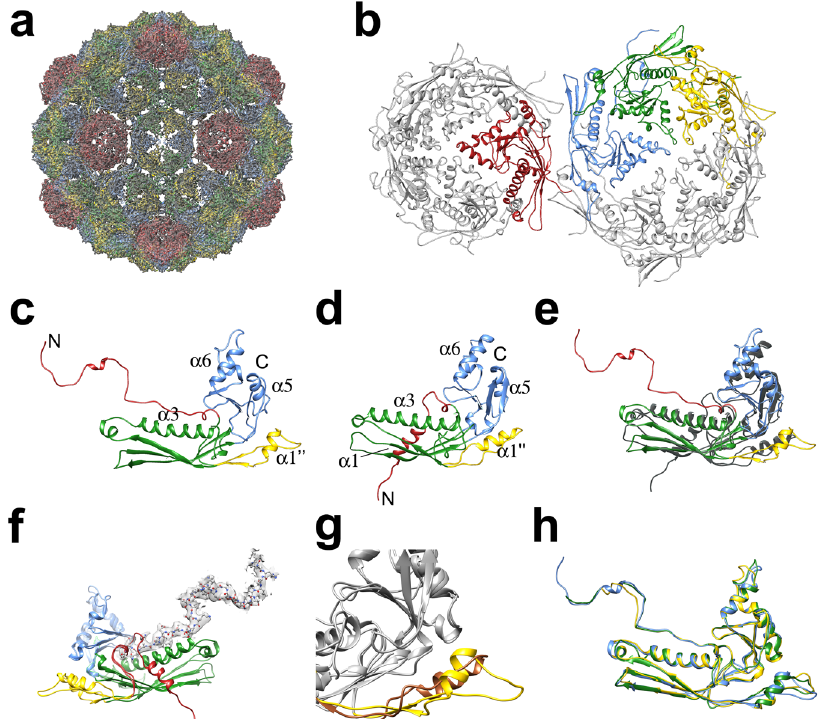
Fig. 6 Atomic model of the SaPIbov5 procapsid. a Ribbon representation of the atomic model for the complete shell fi tted into the density. Ccm occupies the pentamers (position A, red), while CP occupies the hexamer positions B (blue), C (green), and D (yellow). b Ribbon representation of one pentamer and one hexamer. The subunits corresponding to one asymmetric unit are colored as in ( a ). c Ribbon diagram of CP (subunit B), colored according to structural features: N-arm, red; E-loop, yellow; P-domain, green; A-domain, blue. N- and C-termini and pertinent secondary structure features are labeled. d Ribbon diagram of Ccm, colored and labeled as in ( c ). e Superposition of CP (subunit B; colored as in ( c )) and Ccm (gray). f Superposition of CP and Ccm, colored as in ( c ) and viewed from the inside of the shell. The N-arm of CP is shown in ball-and-stick representation, colored according to element, with the corresponding density shown as a transparent gray surface. g Superposition of CP (yellow) and Ccm (brown), showing the E-loops. h Superposition of CP subunits B, C, and D, colored by subunit as in ( a